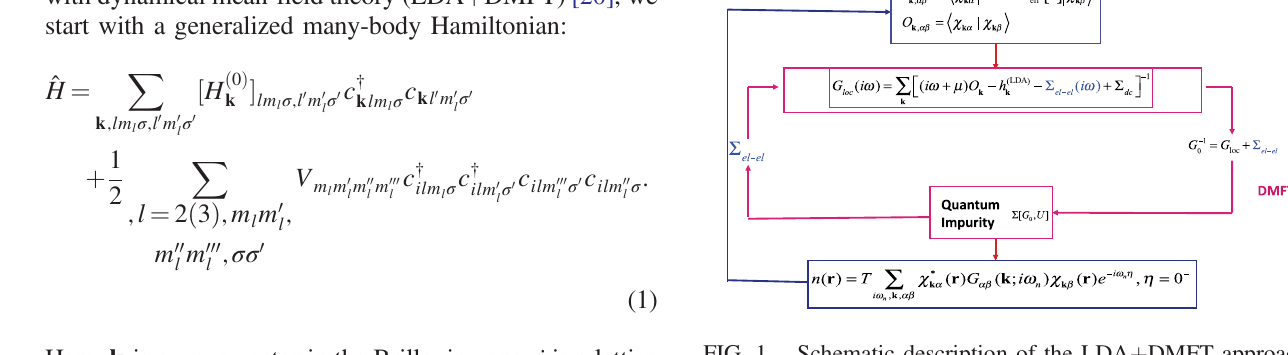
FIG. 1. Schematic description of the LDA þ DMFT